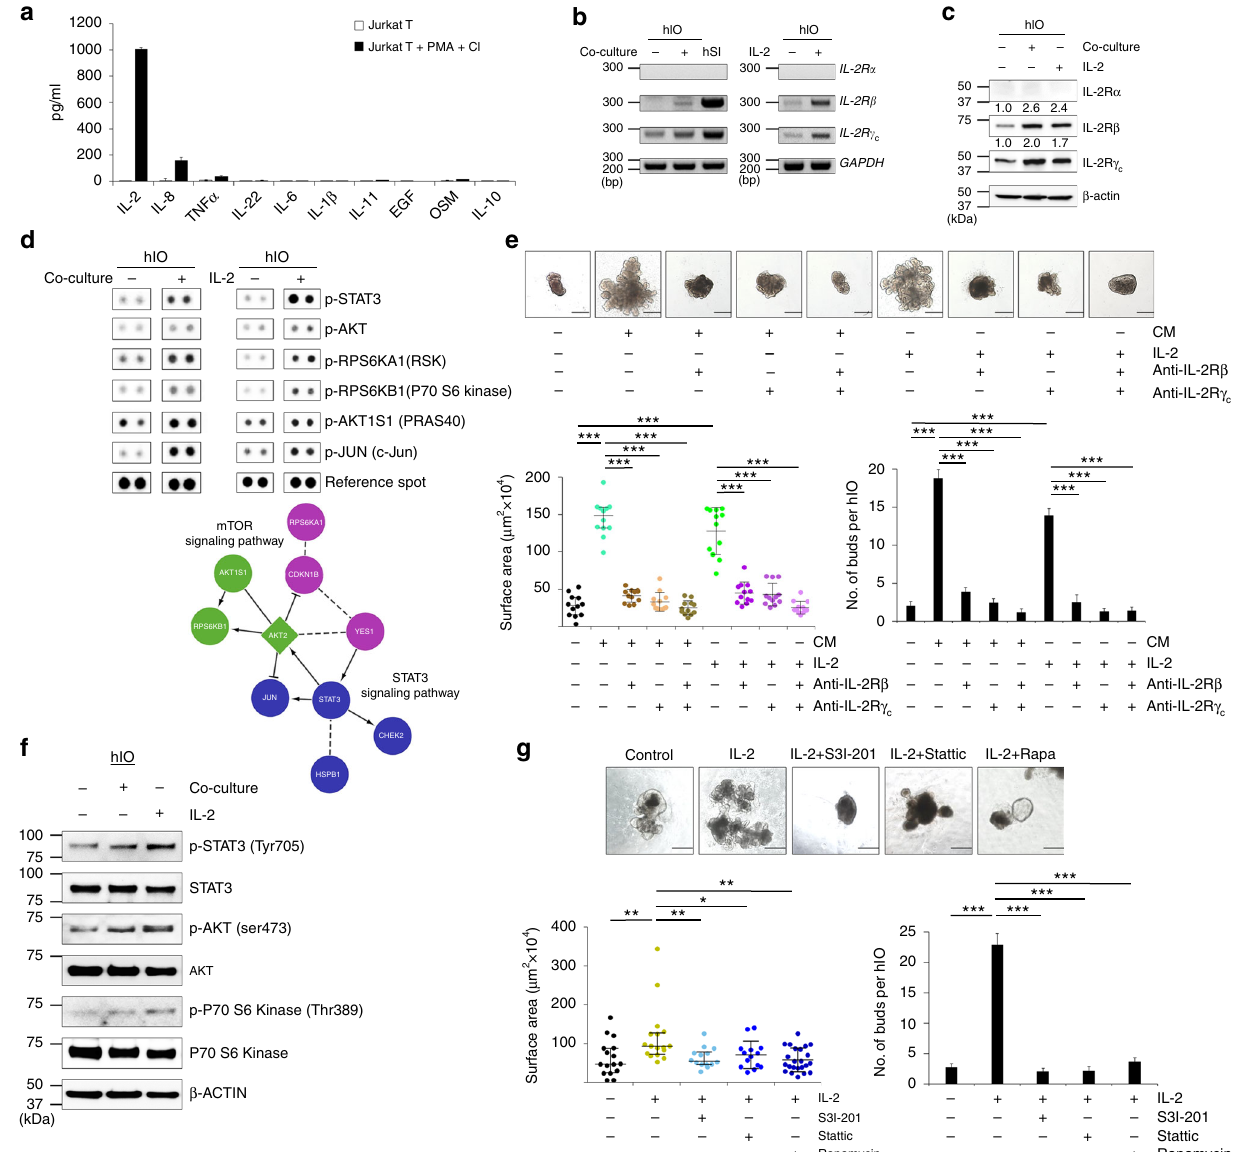
Fig. 2 IL-2 activates STAT3 pathway to induce the in vitro maturation of hIOs. a ELISA quanti fi cation of IL-2, IL-8, TNF α , IL-22, IL-6, IL-1 β , IL-11, EGF, OSM, and IL-10 concentrations in the culture supernatant of stimulated and unstimulated Jurkat T cells. Expression of IL-2R subunits as analyzed by RT-PCR b and Western blot analyses c in co-cultured or IL-2-treated hIOs. d Phosphorylation levels of proteins from multiple signaling pathways in control, co- cultured and IL-2-treated hIOs as reported by a human phospho-kinase array (upper panels). Analysis by functional interaction (FI) network highlighted a signi fi cant enrichment of phospho-proteins in the mTOR and STAT3 signaling pathways (lower panels). In the FI network, arrows represent activating/ catalyzing connections, solid lines ending in a perpendicular line represent inhibition, solid lines represent complexes or inputs and dashed lines represent predicted FI connections. e Representative images of the morphology of hIOs cultured in the presence of 1 ng/ml IL-2, a key component of the co-culture system, or stimulated Jurkat T conditioned medium (CM) with or without IL-2R-inactivating antibodies (anti-IL-2R β , anti-IL-2R γ c ) for two passages. Quantitative assessment of the size of hIOs (left bottom) and the number of budding structure per hIO (right bottom); n = 12 hIOs per group. f Representative Western blot analysis of p-STAT3, p-AKT and p-P70 S6 Kinase levels in co-cultured and IL-2-treated hIOs. g hIOs cultured in the presence of IL-2 (1 ng/ml) with or without the addition of S3I-201 (5 μ M), Stattic (1 μ M) or Rapamycin (Rapa; 10 nM). Quantitative assessment of the size of hIOs after one passage (14 days) (left bottom) and the number of budding structure per hIO (right bottom); n = 14 hIOs per group. Data are presented as mean values of replicates ± SEM. *** p < 0.001, ** p < 0.01, and * p < 0.05 according to t -test. Scale bar, 500 μ